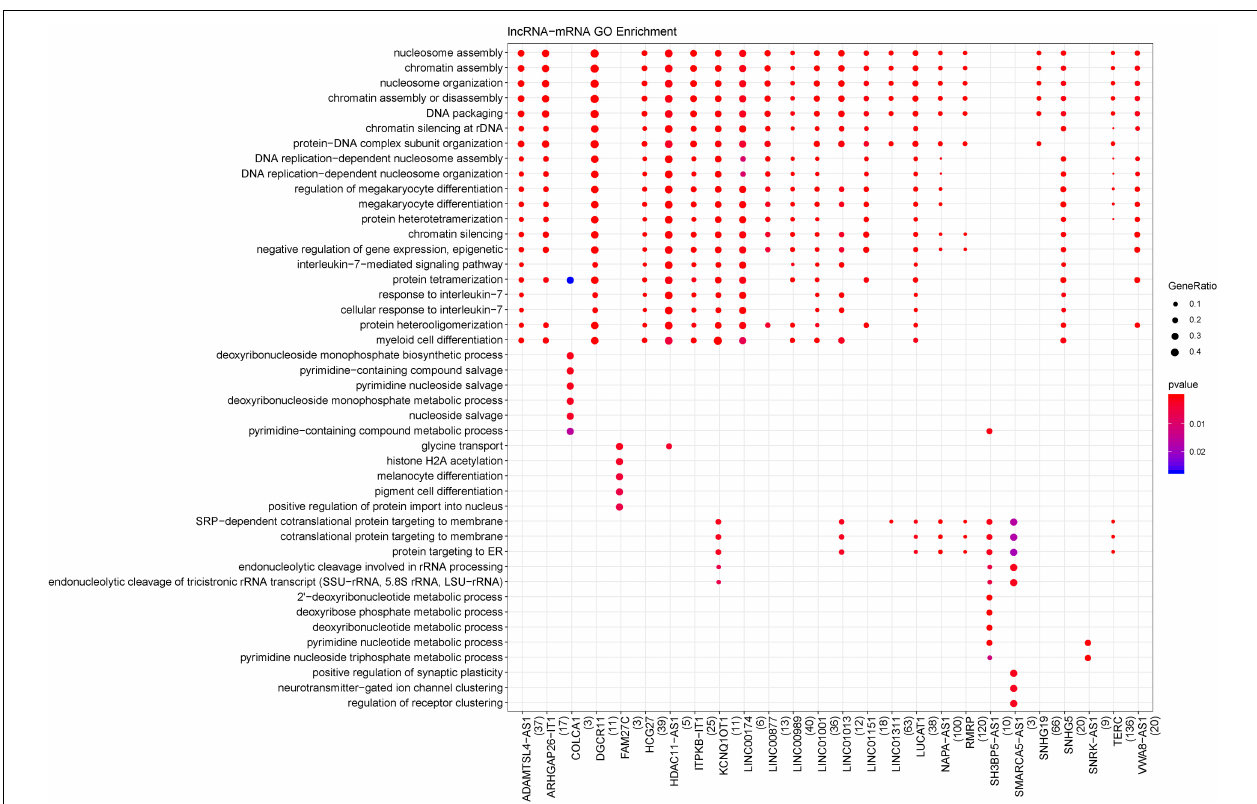
FIGURE 3 | Biological processes enriched by lncRNAs. The changes in bubble color from blue to red indicate that the correlation is significant from low to high. Dot size GeneRatio is gene proportion. The size of the gene specific proportion indicates the proportion of the enrichment item.